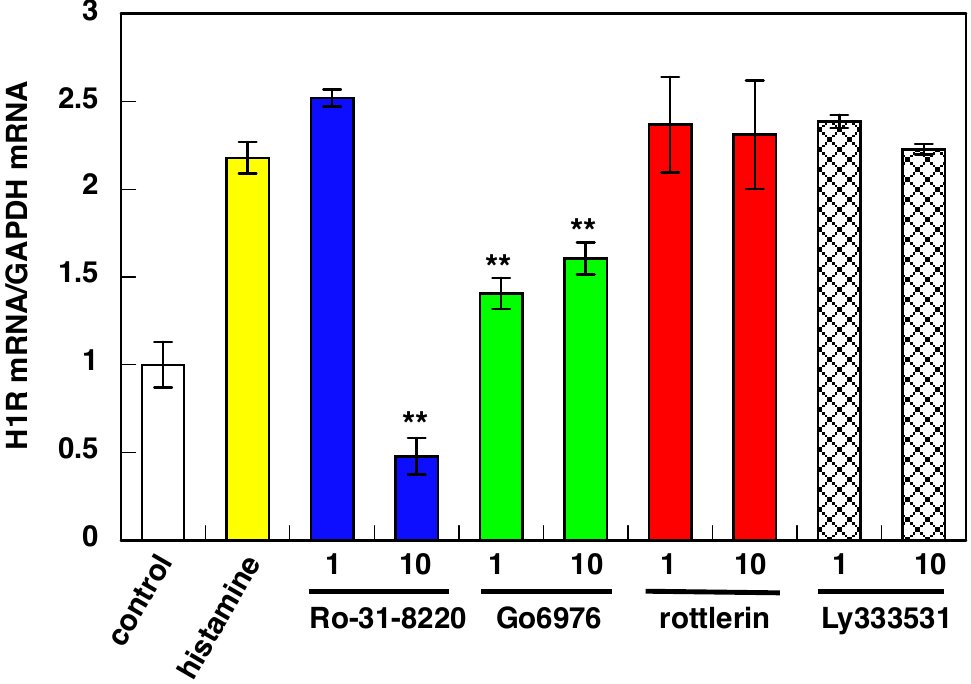
Figure 2. Effect of PKC isozyme-selective inhibitors on histamine-induced upregulation of H1R gene expression in U-373 MG cells. Isozyme-selective PKC inhibitors were treated 1 h before stimulation with 100 µ M histamine. After stimulation, total RNA was isolated, and the H1R mRNA level was determined by real-time RT-PCR. Inhibitors used are as follows: Ro-31-8220 (pan-PKC inhibitor), Go6976 (PKC α / β 1 inhibitor), rottlerin (PKC δ inhibitor), and Ly333531 (PKC β inhibitor). Data are represented as means ± SEM ( n = 9). ** p < 0.01 vs. histamine. For statistical analysis, one-way ANOVA with Tukey–Kramer’s test was